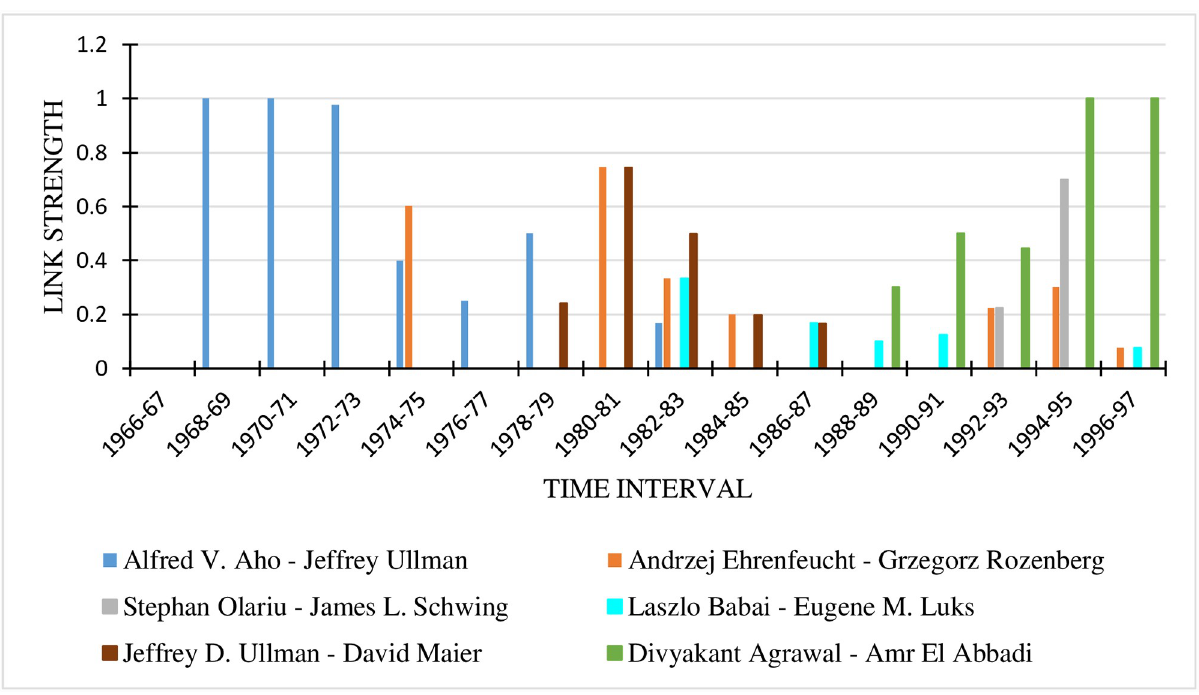
Fig 6. Link strengths between authors for 2-year time